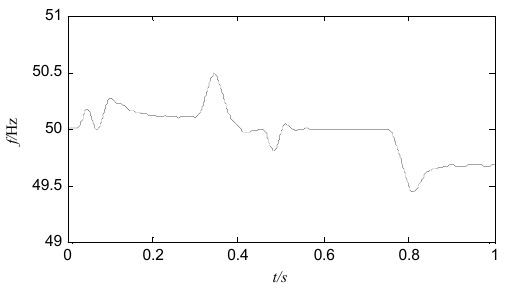
Figure 24. The frequency response of micro ‐ grid.